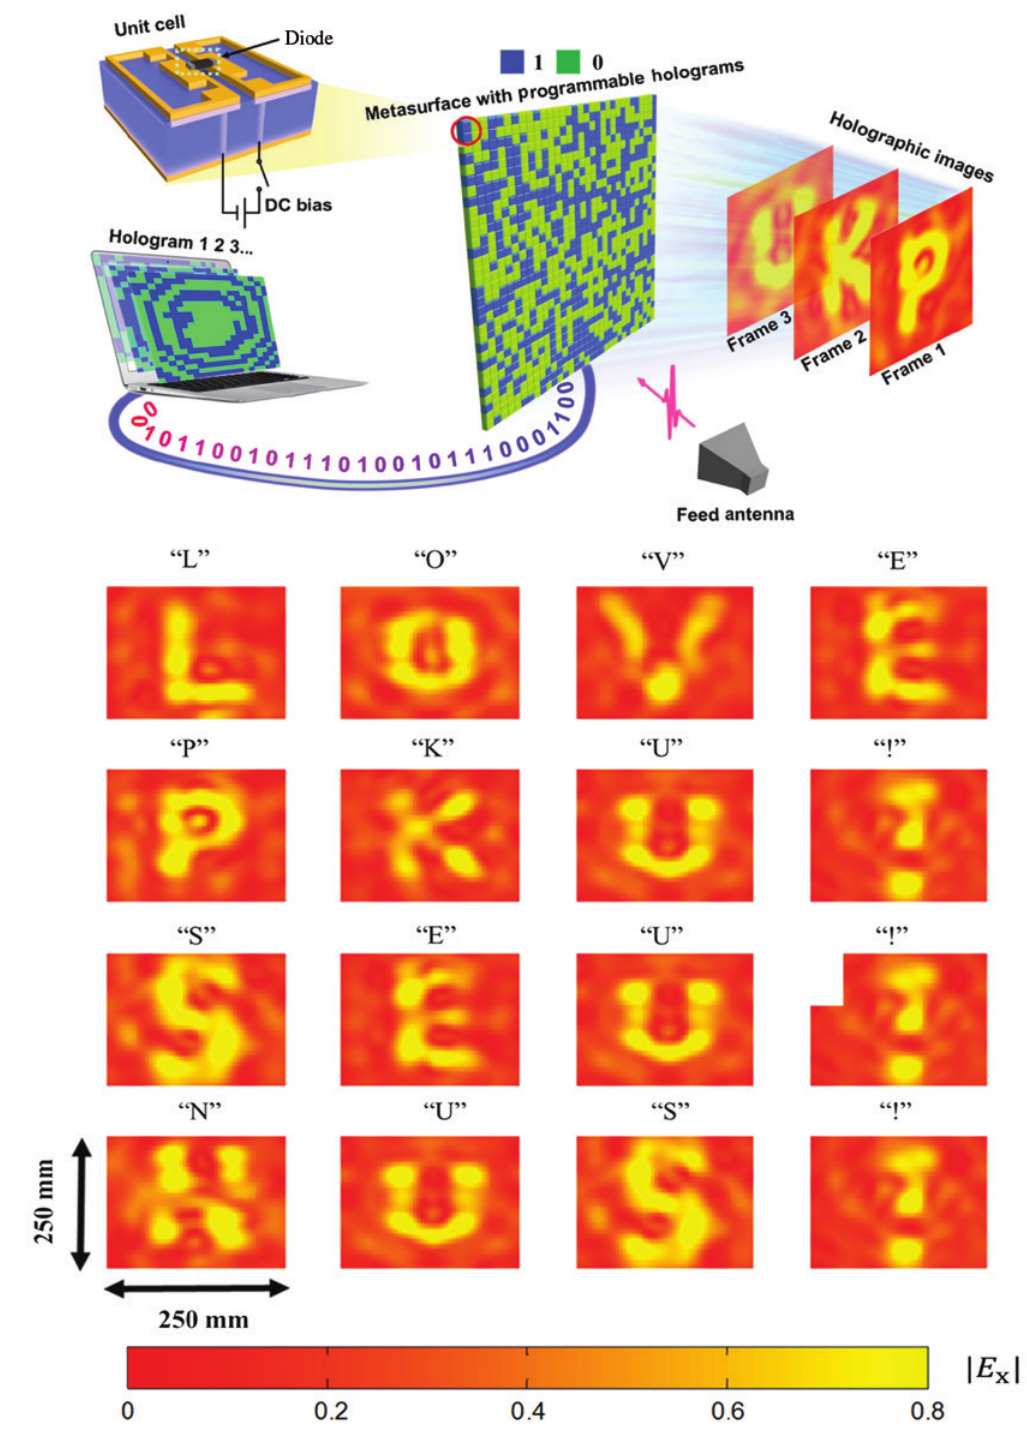
Figure 9: The programmable holographic imaging based on the 1-bit information metasurface. (top pannel) A sketch of the proposed dynamic holographic imaging. The metasurface in the middle is formed by an array of meta-atoms, each having a pin-diode welded between the two metallic loops and independently controlled by a DC voltage through a via (see the unit cell in the upper-left corner). A computer digitally controls the metasurface by dynamically changing the phase distribution (Holograms 1, 2, 3 … ) computed from the modified GS algorithm. Under the illumination of a feeding antenna (on the bottom right side), the metasurface hologram can successively project the holographic images (Frames 1, 2, 3 … ) at the imaging plane (Zr), showing the letters “P,” “K” and “U.” (bottom panel) The experimentally observed holographic images (Ex-field intensity) of “LOVE PKU! SEU! NUS!” measured at the image plane of Zr = 0.4 m. Adapted from